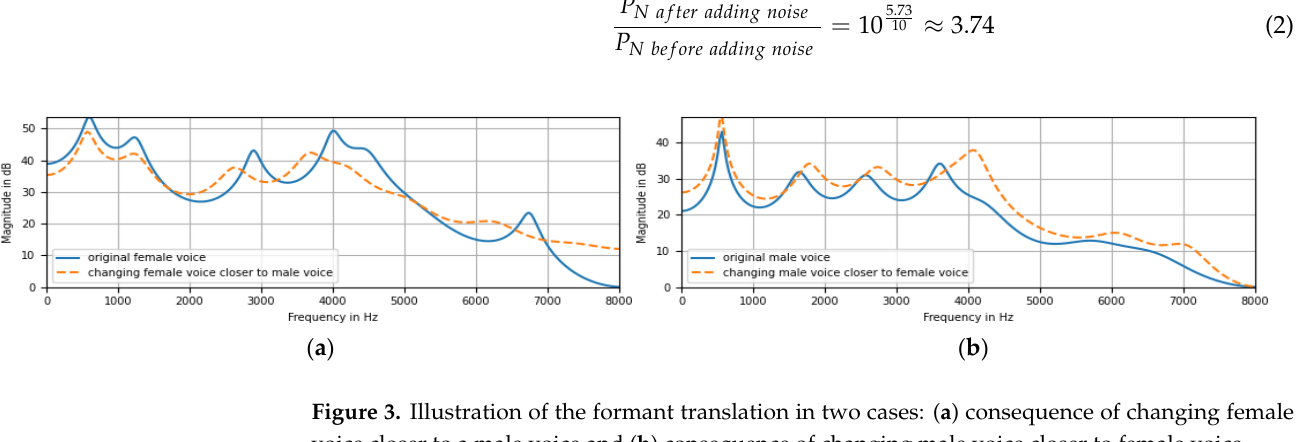
White noise was added to the speech signal using Librosa. The white ‐ noise ampli ‐